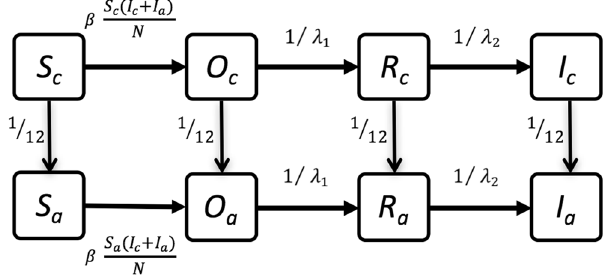
Figure 1. Graphical representation of the compartmental model used to represent within-herd transmission dynamics, including calves ( c , top row) and adults ( a , bottom row). Number of individuals in each infection class is indicated as susceptible ( S ), occult/exposed ( O ), reactive (to skin testing, R ), and infectious ( I ). Total herd size is represented as N. β indicates the rate of transmission between infectious and susceptible individuals, and λ 1 and λ 2 represent the duration of the occult and reactive periods, respectively. Calves transition to adults after twelve months, which is equivalent to 1/12 on the monthly time scale of the